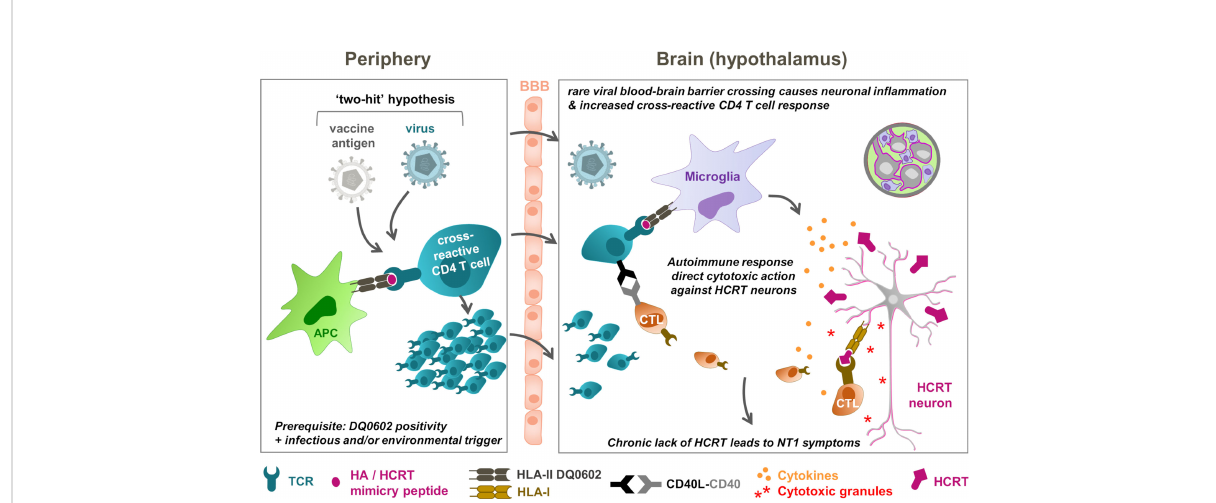
FIGURE 2 NT1 immunopathogenesis model: T-cell cross-reactivity and “ two-hit ” hypotheses. The hypothetical model connects peripheral (left) and hypothalamic (right) events. In this model, rare conditions, including brain injuries or pathogens (A/H1N1pdm09 virus, Streptococcus ) crossing the blood-brain barrier (BBB), prime for local brain in fl ammation and, due to immune surveillance, the expansion and migration of T cells from the periphery into the brain. In DQ0602-positive persons, these T-cell responses could include DQB1*0602 (DQ0602)-restricted, haemagglutinin (HA)/hypocretin (HCRT) – cross-reactive CD4 + T cells, as a “ fi rst hit ” . These low-frequency immune responses could then be ampli fi ed by an independent event ( “ second hit ” ), which in highly rare occasions might have been a vaccination that stimulates CD4 + T-cell responses. Further response ampli fi cation due to ‘ epitope spreading ’ and autoimmune recognition of epitopes in HCRT peptides from the hypothalamic HCRT neurons, may then activate the HCRT-speci fi c T cells to launch immune attacks on these neurons. These attacks are mediated by cytokine release and cytotoxic (CD8 + ) T lymphocyte (CTLs) that are ‘ licensed to kill ’ by the CD4 + T cells. The subsequently released cytotoxic granules, containing perforin and granzymes, directly attack the virus-infected neurons upon HLA-I mediated antigen recognition. The progressive loss of the HCRT neurons ultimately results in type-1 narcolepsy (NT1) symptoms in the affected person. Note that failure of peripheral tolerance may constitute a third parameter that could affect risk. APC, antigen-presenting cell. TCR, T-cell receptor. HLA, human leukocyte antigen. CD40L, CD40